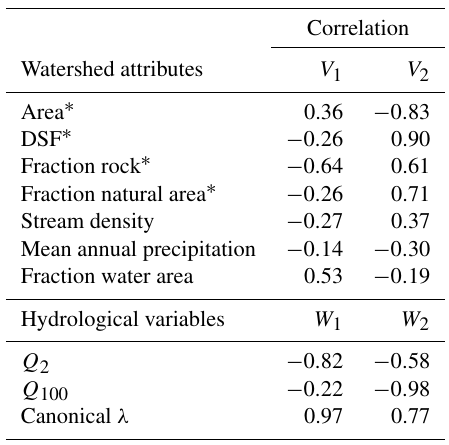
Figure 2. Observed versus predicted estimates for (a) Q 2 and (b) Q 100 . The dashed grey line depicts the linear regression be- tween observed and predicted flow values, and the black, solid line shows a 1 : 1 relationship. Table 2. Canonical correlation coefficients for watershed attributes and hydrological variables of hydrological research stations from the canonical correlation analysis. Those variables used in multiple regression equations are denoted with a “ ∗